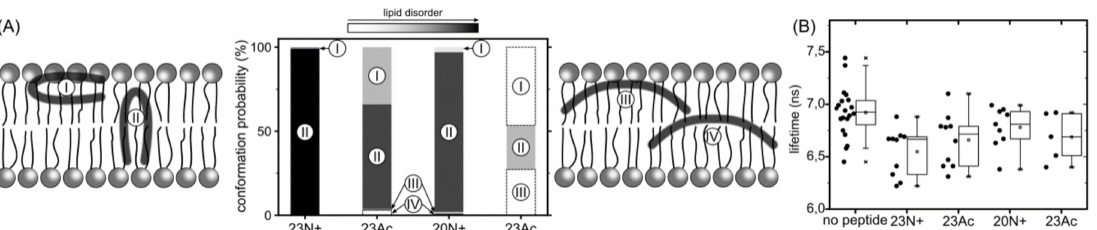
Figure 6. ( A ) Surface and deep-embedded configurations of a helical hairpin and boomerang (I and III, and II and IV, respectively) with their probabilities (bar heights) and impact on lipid disorder (gray level). ( B ) Lipid disorder induced by HAfp peptides measured as experimental lifetime NBD-C6 values in giant unilamellar vesicles (GUV). Nonparametric Wilcoxon-Mann-Whitney test: p < 0.05 between “no peptide” and all the peptides; between N+ and Ac p > 0.1 for both peptide lengths. ( C ) Representative Fluorescence-lifetime imaging microscopy (FLIM) images of GUVs, scale bar 5 µ m. Corresponding fluorescence intensity decays with fits can be found in Supplementary Figure